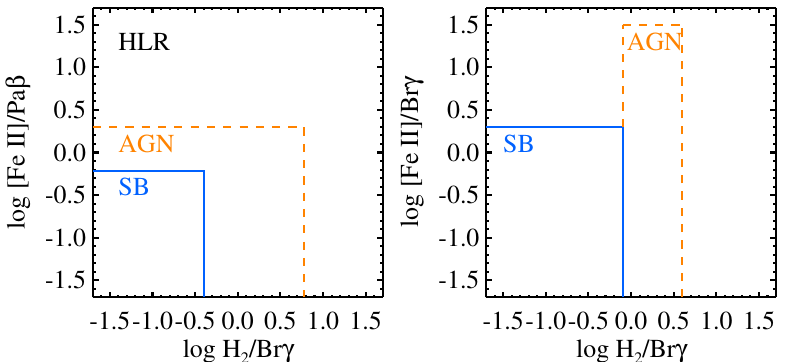
Figure 6. Two near-infrared diagnostic diagrams to distinguish between excitation from starburst (SB; blue) and AGN (orange) as well as the high line ratio (HLR). The left panel shows the [Fe II ]/Pa β ver- sus H 2 /Br γ diagram in the logarithmic scale, as derived from Riffel et al. [101,103]. The right panel shows the [Fe II ]/Br γ versus H 2 /Br γ diagram in the logarithmic scale, following Colina et al. [102]. These boundaries are derived from spatially-resolved observations of nearby Seyfert and LIRGs,